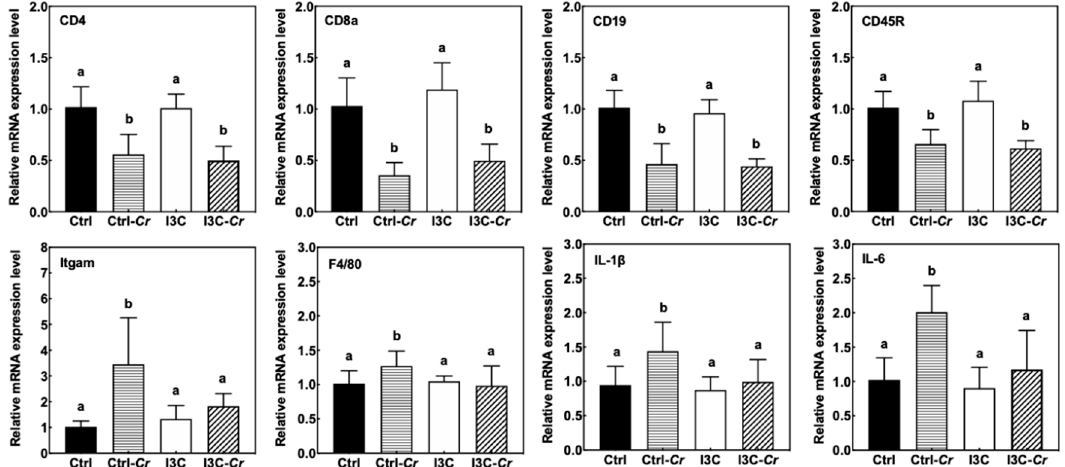
Figure 8. I3C significantly attenuated Cr-induced increases in mRNA levels of macrophage makers (Itgam and F4/80) and proinflammatory cytokines (IL-1 β and IL-6) in the spleen. Results are expressed as the mean +/ − SD fold-change (n = 8). Ctrl: control diet; Ctrl-Cr: control diet, Cr-infected; I3C: I3C diet; I3C-Cr: I3C diet, Cr-infected. Significant differences ( p < 0.05) between groups are identified by different letters.